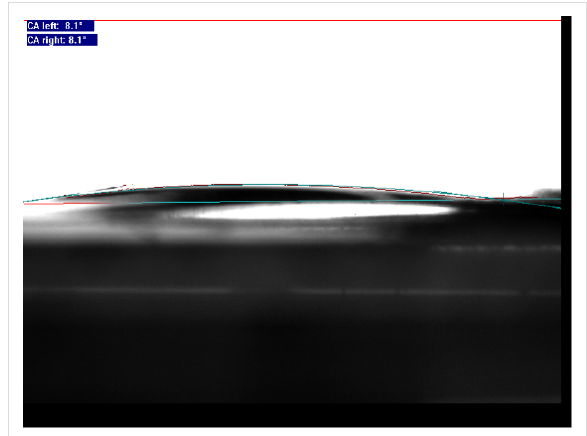
Figure 5: Contact angle of the coating after charging for 2 min at 2000 V.